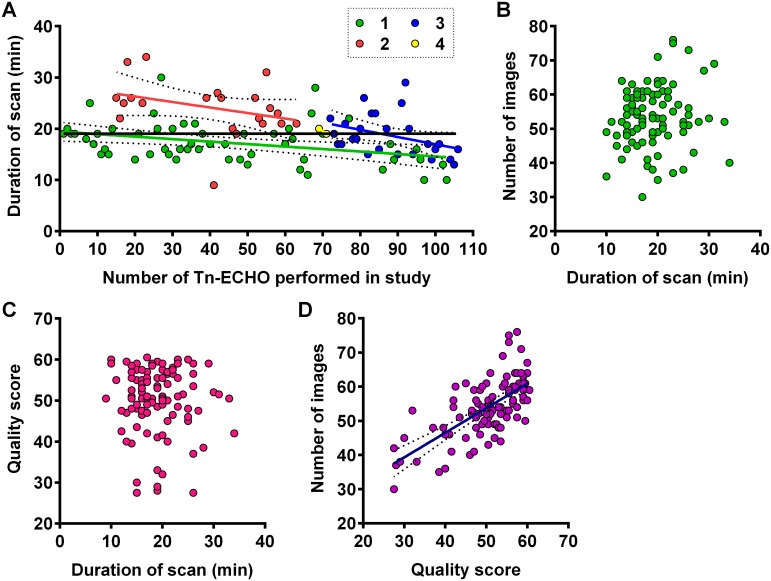

(A) Decrease in scan time among each TNE operator (1 to 4) with increasing number of Tn-ECHO scans over the progression of the study. Relationship (B) between quality and duration of Tn-ECHO scan, (C) between of number of images acquired and duration of Tn-ECHO scan, and (D) between quality of Tn-ECHO scan and number of images acquired. Linear regression (solid lines) with 95% confidence limits (dotted lines).